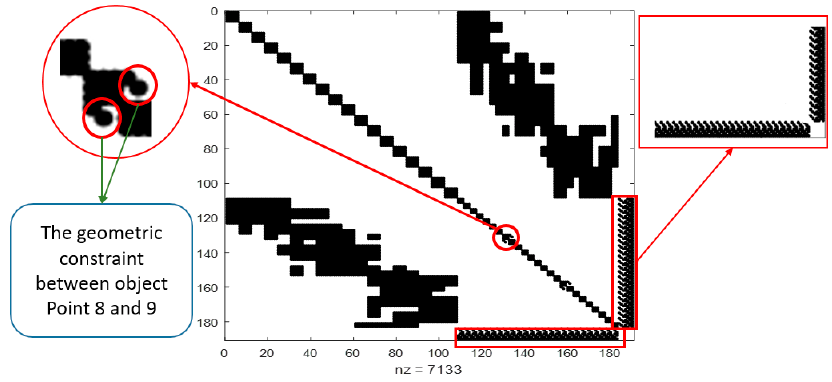
Figure 13. Normal matrix with all object points constrained by inner matrix G and Geometric Constraint. Table 5. The calculated final 3D ground coordinates of the accuracy of the tie points.